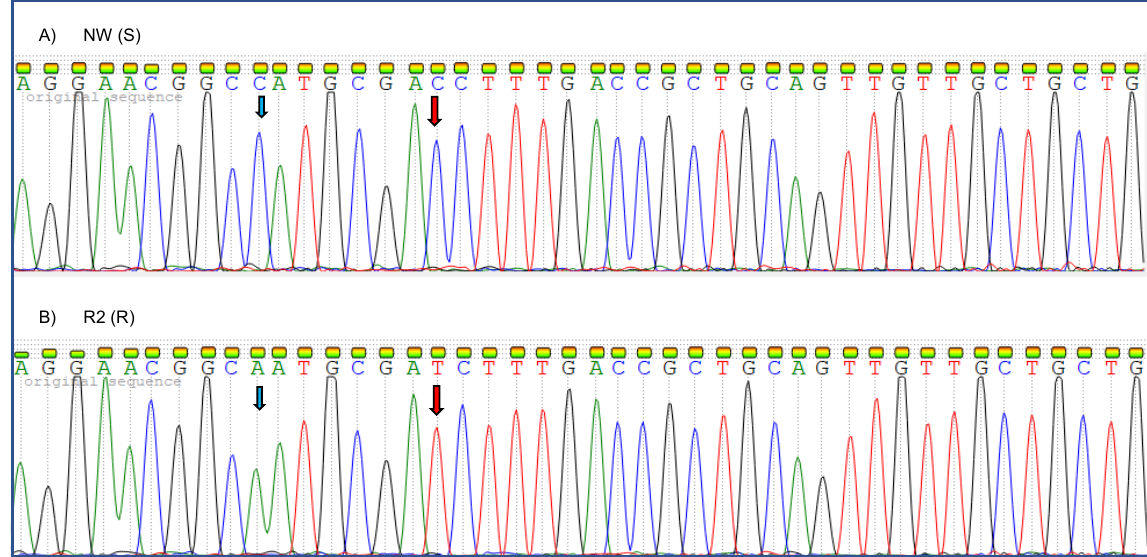
Figure 6. Electropherograms depicting 41 bp of EPSPS for ( A ) susceptible NW (S) and ( B ) resistant R2 (R) plantago ( Plantago lanceolata L.) biotypes in the sense direction. Cytosine to Adenine transition DNA variant shown by the blue arrow. The red arrow denotes the position of the DNA variant in EPSPS of plantago, which substitutes a dCTP with a dTTP in the resistant